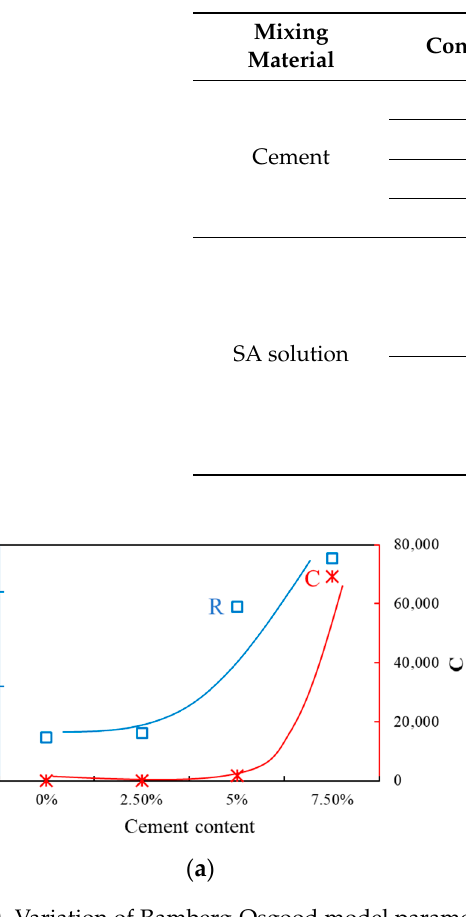
Figure 9. Variation of Ramberg-Osgood model parameters R and C versus ( a ) cement content, ( b ) sodium alginate (SA) solution concentration.